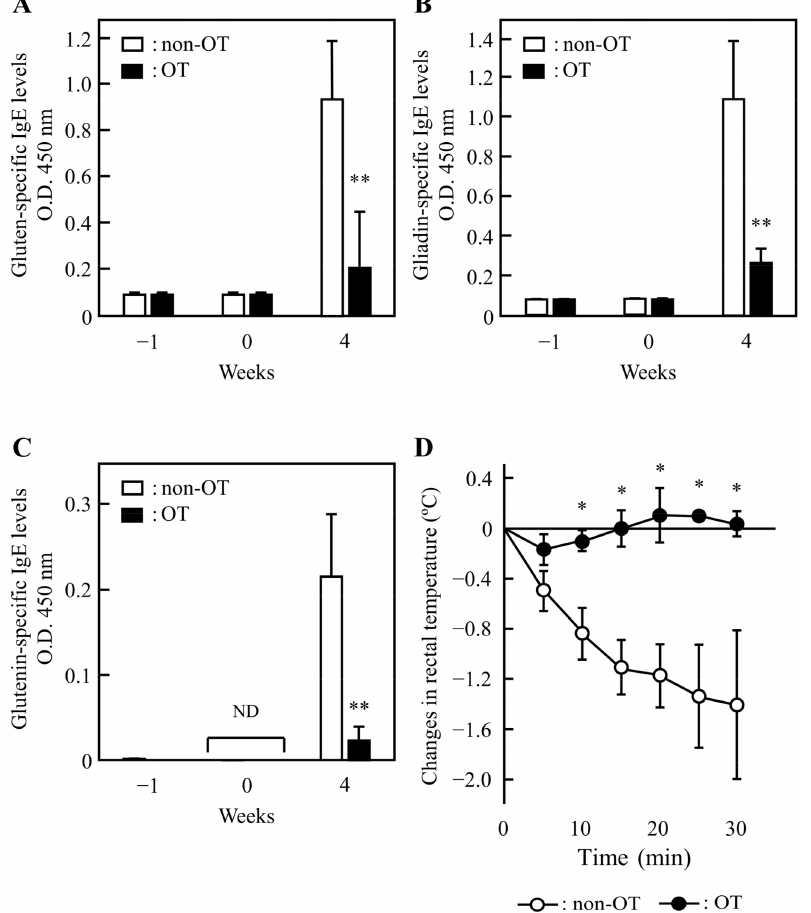
Figure 3. The induction of oral tolerance (OT) to gluten and its components in gluten-immunized rats. The levels of IgE Abs specific for gluten ( A ), gliadin ( B ), and glutenin ( C ) in plasma were determined at weeks − 1, 0, and 4 in rats immunized subcutaneously with gluten (week 0) following the oral administration of vehicle alone (50% ethanol, non-OT) or 10 mg of TCI gluten (OT) daily for 5 days. Changes in rectal temperature ( D ) were evaluated after the administration of gluten (2 mg/kg) intravenously at week 4. Each value represents the mean ± SD of three to six rats. * p < 0.05, ** p < 0.01: significantly different from non-OT rats. ND, not